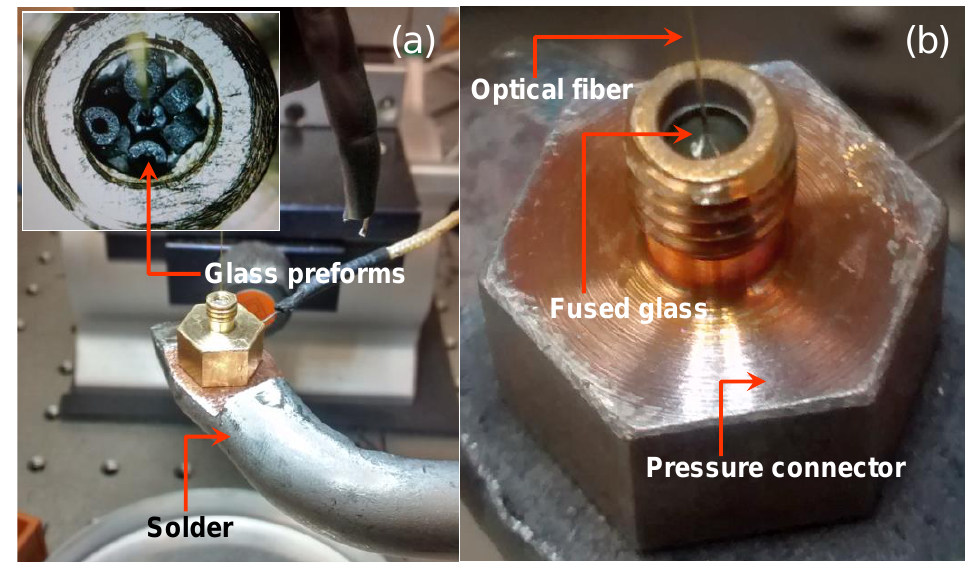
Figure 5. ( a ) Hole of a pressure connector filled with the glass preforms. An iron solder is used to melt the glass preforms and ( b ) a view of the melted glass sealing the optical fiber.